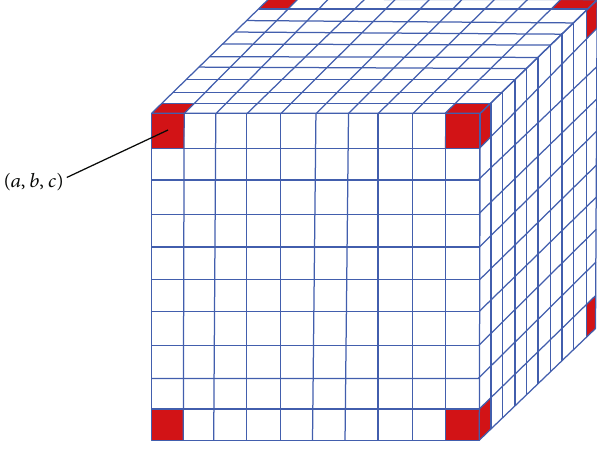
Figure 4: Sketch map of core